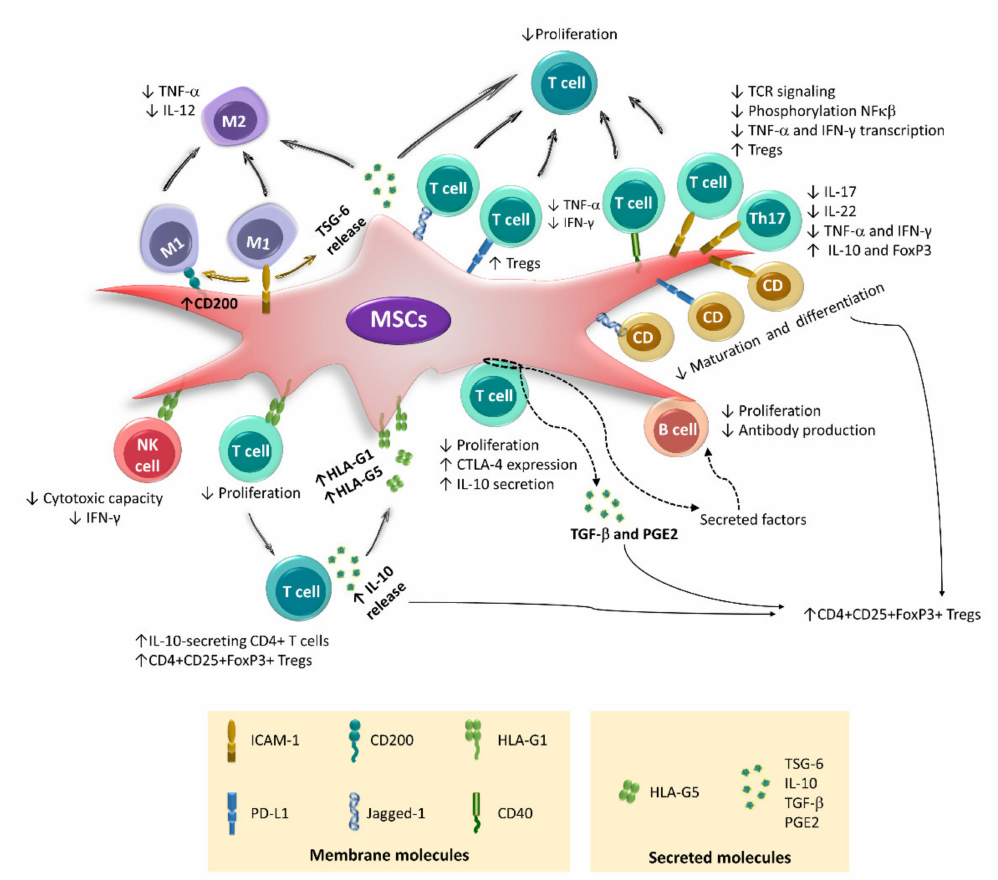
Figure 2. Immunoregulatory mechanisms mediated by cell–cell contact. The main membrane molecules involved in the immunoregulation exerted by MSCs are shown. Cell–cell interactions, in addition to affecting the proliferation, differentiation, and effector function of immune cells, also increase the immunoregulatory capacity of MSCs. The contact of M1 macrophages with MSCs through ICAM-1 induces an M2 phenotype in macrophages, while in MSCs, the expression of CD200 and TSG-6 is increased (brown arrows), which also favors the differentiation of M2 macrophages. Conversely, ICAM-1, PD-L1, and jagged-1 decrease the secretion of cytokines and proliferation of activated T lymphocytes, as well as the maturation and differentiation of DCs. Furthermore, CD40 affects the proliferation of T cells, while HLA-G1 induces Tregs differentiation. HLA-G1 is also involved in the decrease in effector function of NK cells. Conversely, direct contact of MSCs with T lymphocytes (circle with dotted lines) induces changes in T lymphocytes and stimulates the secretion of TGF β and PGE2, as well as factors that affect the function of B lymphocytes (dotted lines). However, it is unknown exactly which molecules are involved in this